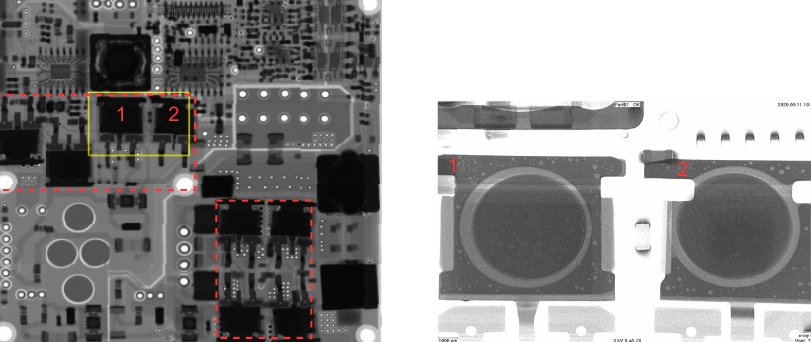
Figure 6. A top view X-ray scan of an LVPS Brick post reflow and before the manual population of the remaining components ( Left ). An enlarged bottom view X-ray scan of the switching MOSFET (1) and diode (2) post reflow ( Right ). These are the very same components labelled 1 and 2 in ( Left